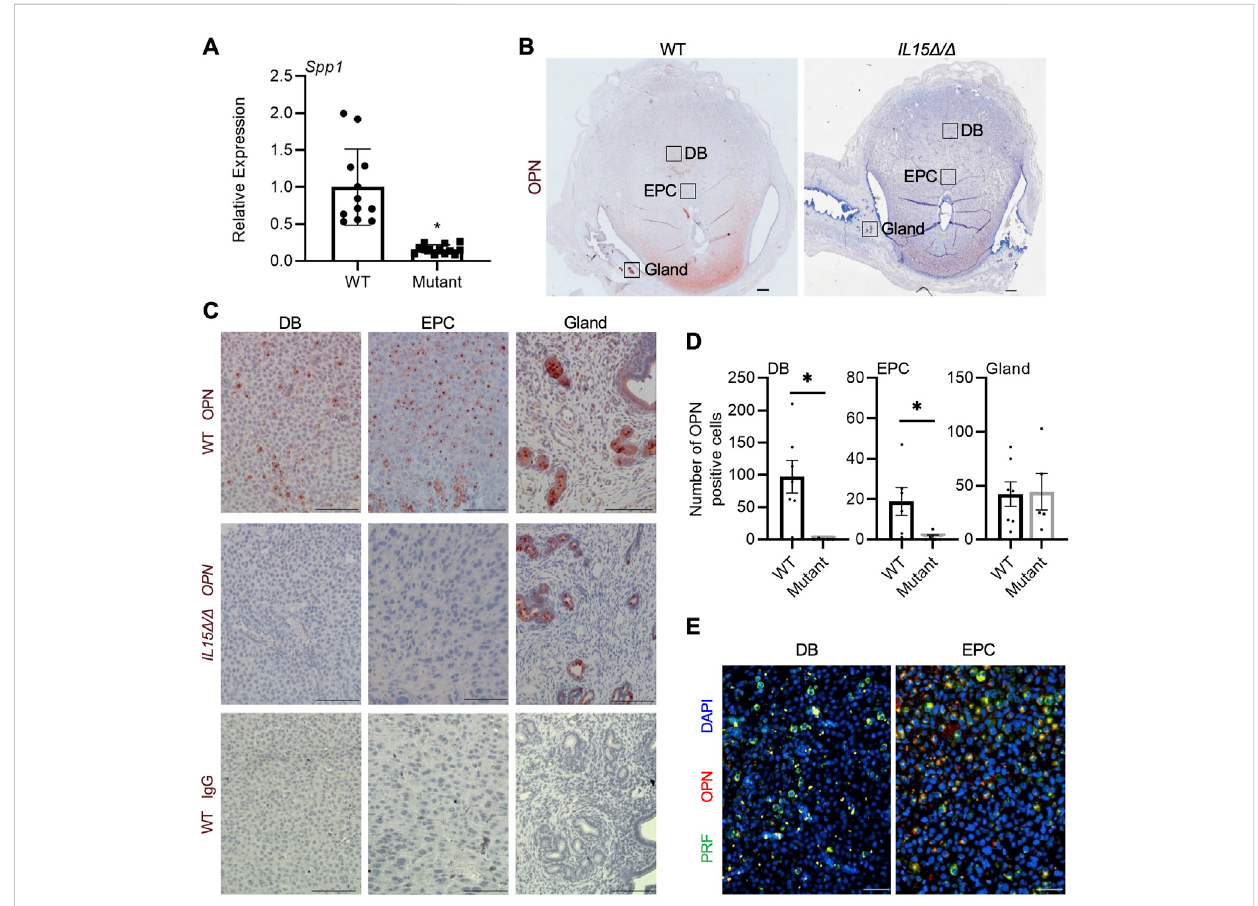
Reduced OPN in the decidua of IL15 Δ / Δ rats. (A) Relative expression of Spp1 mRNA in WT versus IL15 Δ / Δ (mutant) implantation sites on GD 9.5 ( N ≥ 13 implantation sites from at least 5 dams per group). (B) Images of OPN immunohistochemistry in WT versus IL15 Δ / Δ implantation sites. Scale bar, 250 µm. The boxes show the approximate location of high magni fi cation images in (C) for the decidua basalis (DB), near the ectoplacental cone (EPC), and at the periphery with uterine glands. (C) Higher magni fi cation images showing OPN localization in the DB, near the EPC, and uterine glands of WT and IL15 Δ / Δ implantation siteson GD9.5. The bottom panels show images captured following immunohistochemistry ofWT implantation sitesusing anon-speci fi cmouseIgG 1 inplaceofOPN.Scalebar,50 µm. (D) Quanti fi cationofOPN-positivecellsinDB,EPC,anduterineglandsfromWTand IL15 Δ / Δ implantation sites ( N ≥ 5 implantation sites from different dams per group). (E) Immunohistochemistry for PRF (green) and OPN (red) in a representative WT GD 9.5 implantation site. Images were taken of the DB and near the EPC. Please note that PRF and OPN frequently colocalize. Scale bars